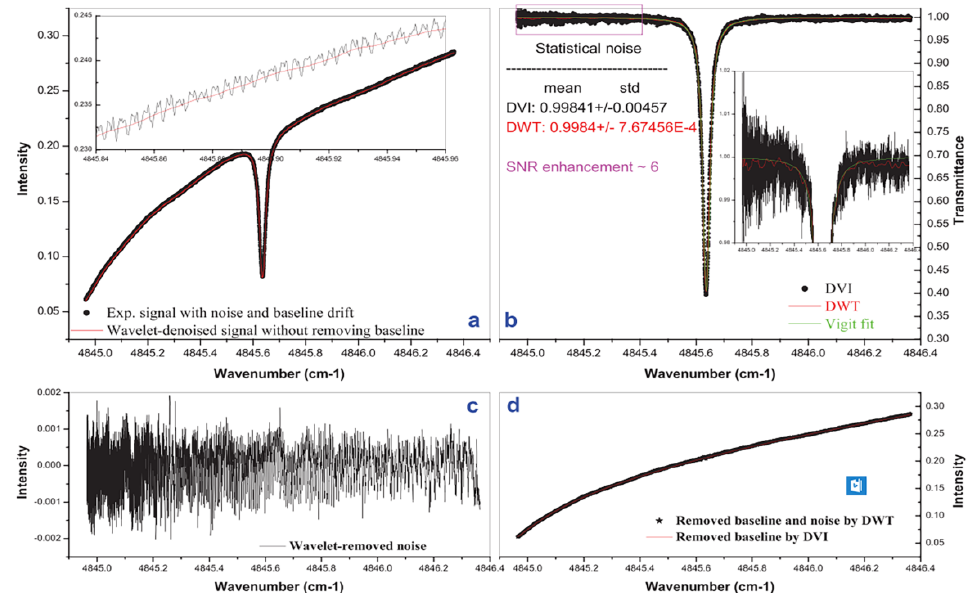
Figure 14. ( a ) Experimental spectrum of CO 2 (pressure = 140 mbar; path length = 4800 cm; mixing ratio = 1.0%; temperature = 292.95 K) and wavelet–denoised signal; ( b ) Baseline drift removed transmittance signals using DVI and DWT, as well as the Voigt fit; ( c ) DWT removed noise; ( d ) DWT removed baseline with noise and DVI removed baseline. Parts of the “baselines” are expanded for clarity and statistical noises are also provided in the inset. This figure was obtained from [52].